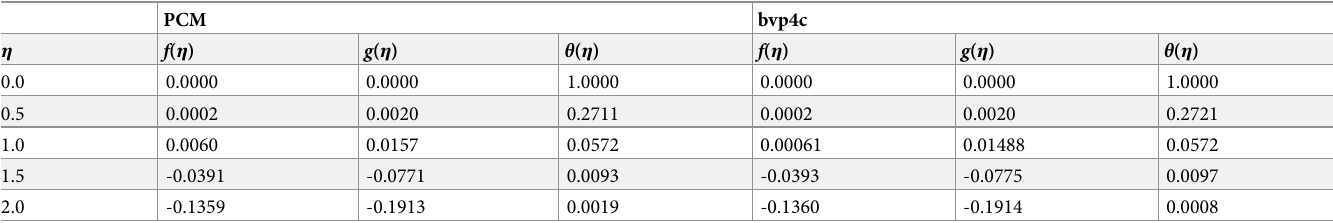
Table 2. Comparative analysis between PCM and bvp4c method.